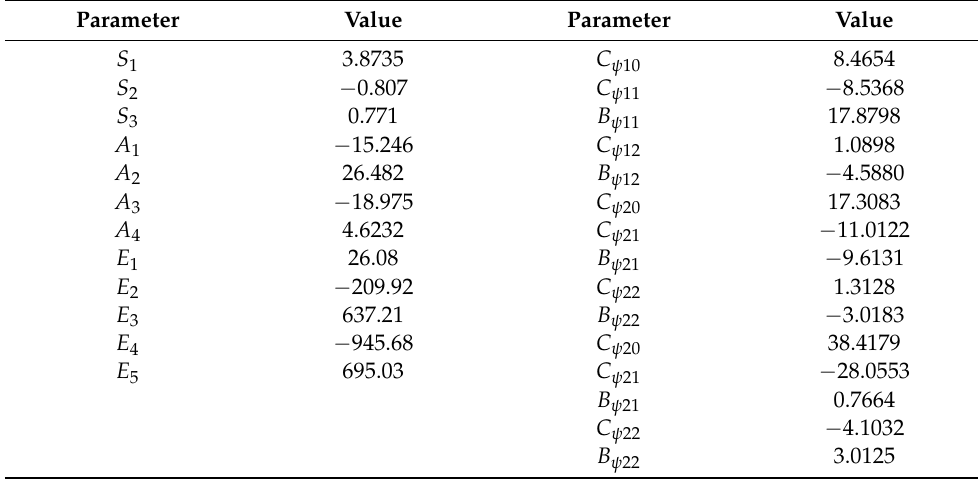
Table 2. Coefficients of the geometric model and the kinematic model of a seagull.